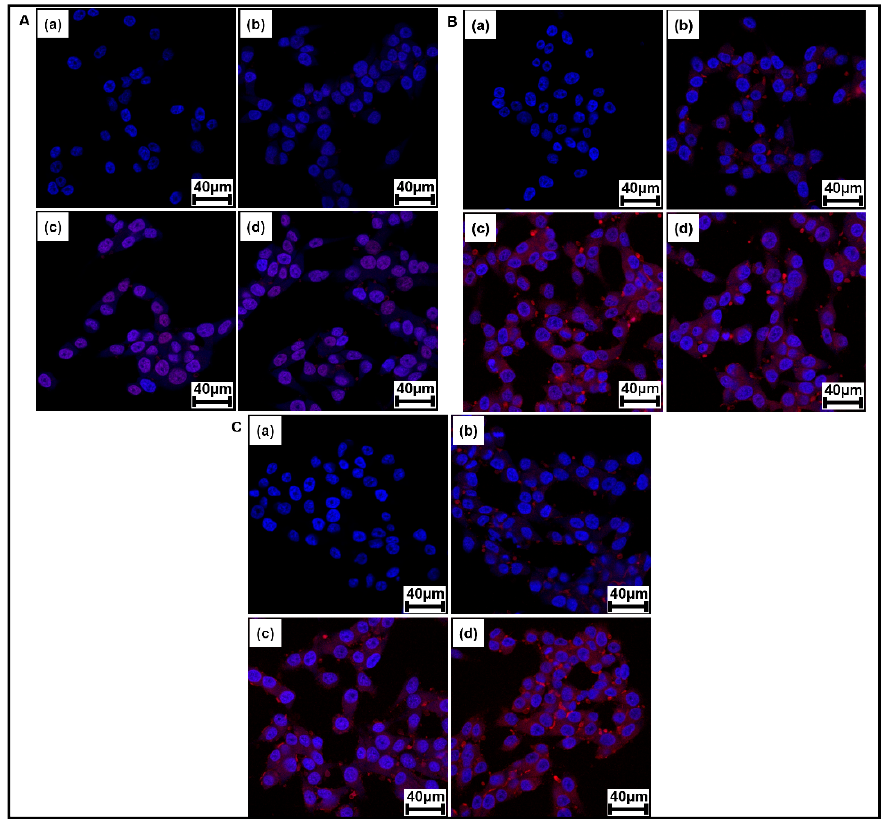
Figure 11. CLSM images of KB cells treated with free DOX ( A ), P(HEA- co -PVS)(97 / 3) / DOX micelles ( B ), and P(HEA- co -ABZ) / DOX micelles ( C ) after the treated cells were incubated for 0 ( a ), 0.5 ( b ), 2 ( c ) and 4 h ( d ).